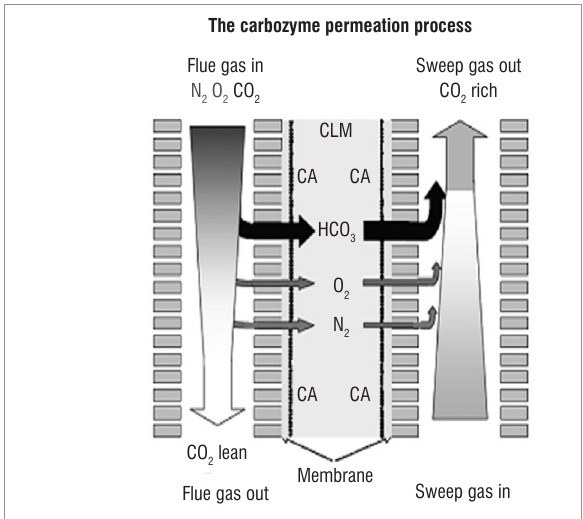
separation using the carbonic anhydrase (CA) enzyme. 2 Figure 7: CO 2